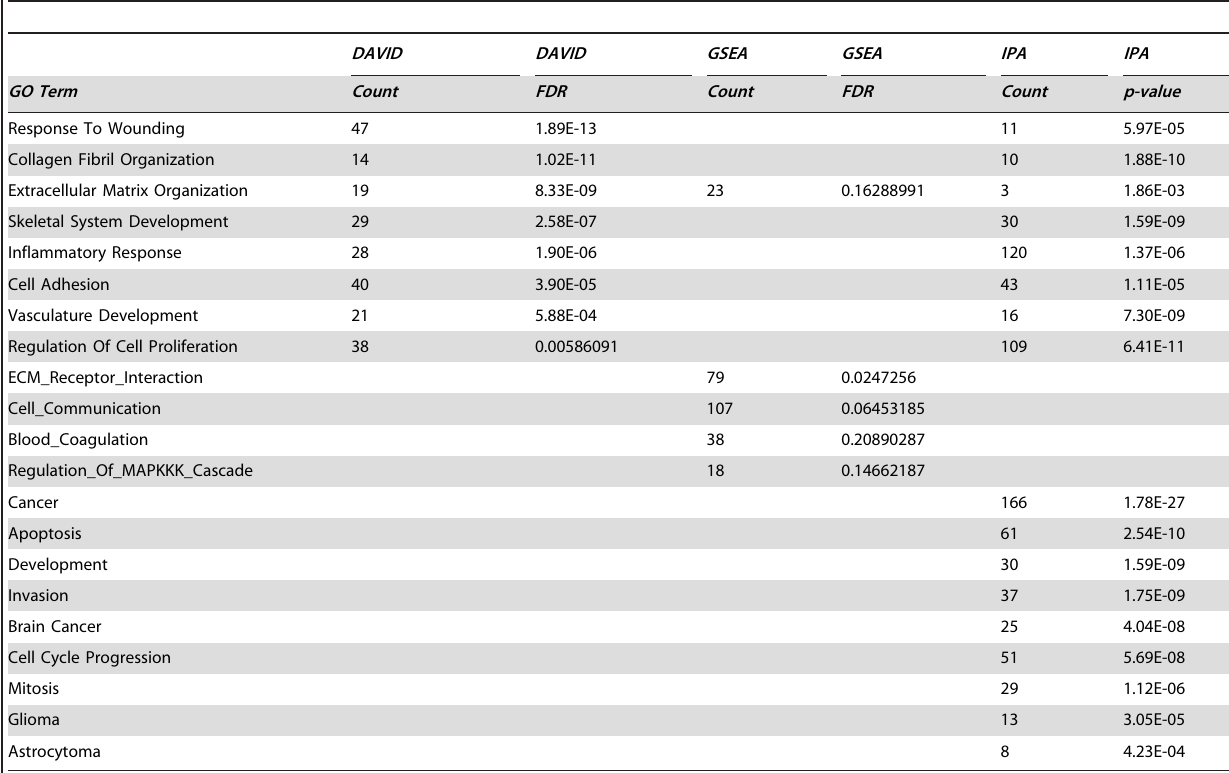
Table 5. Significant Gene Ontology and Pathway Annotations identified for 576 probes corresponding to 395 unique genes differentially expressed between Proneural Oligodendrogliomas/Astrocytomas and Proneural